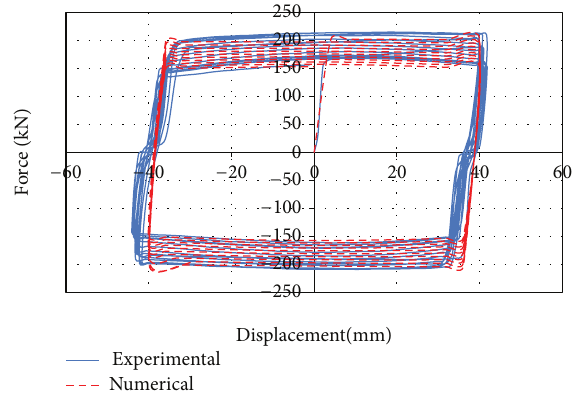
Figure 10: Comparison between numerical and experimental results (case C).